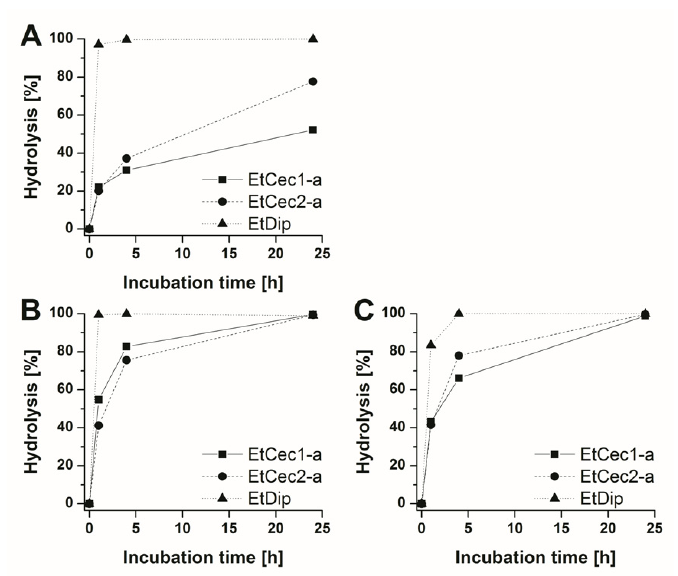
Figure 4. Percent hydrolysis of the Eristalis tenax AMPs EtCec1-a, EtCec2-a and EtDip after incubation in plasma from ( A ) human, ( B ) mouse, and ( C ) rat ( n = 3).